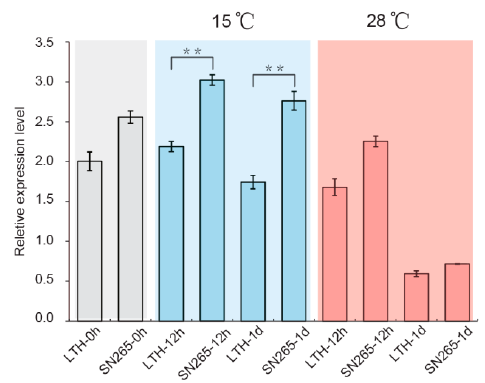
Figure 5. The expression analysis of the candidate gene of qLTG6 . Relative expression